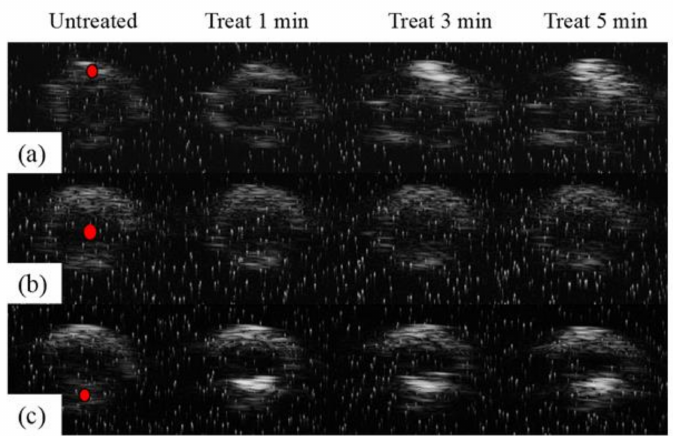
Figure 14. Results of different treatment foci on the ultrasound imaging function of the integrated system: ( a ) the treatment focus on the superior wall of the blood vessel; ( b ) the treatment focus on the middle of the blood vessel; ( c ) the treatment focus on the inferior wall of the blood